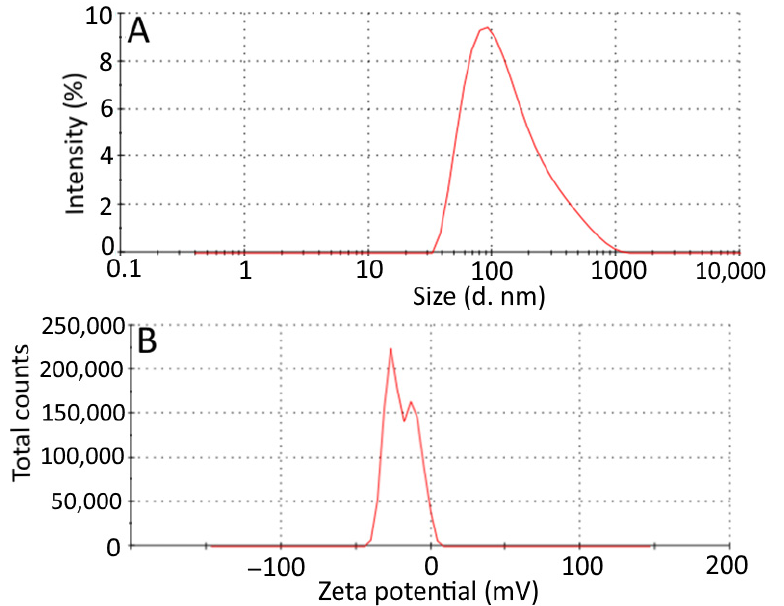
Figure 4. Characteristics of Azadirachta indica oil included nanohydrogel. Average droplet size ( A ) and ( B ) zeta potential.